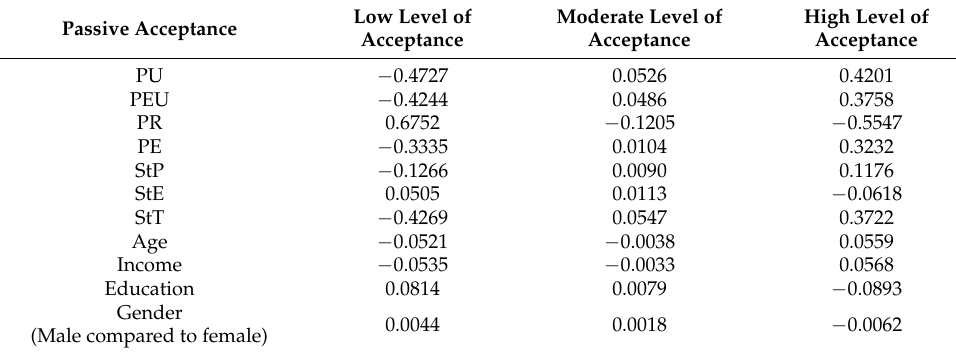
Table 4. Marginal effects (passive acceptance).